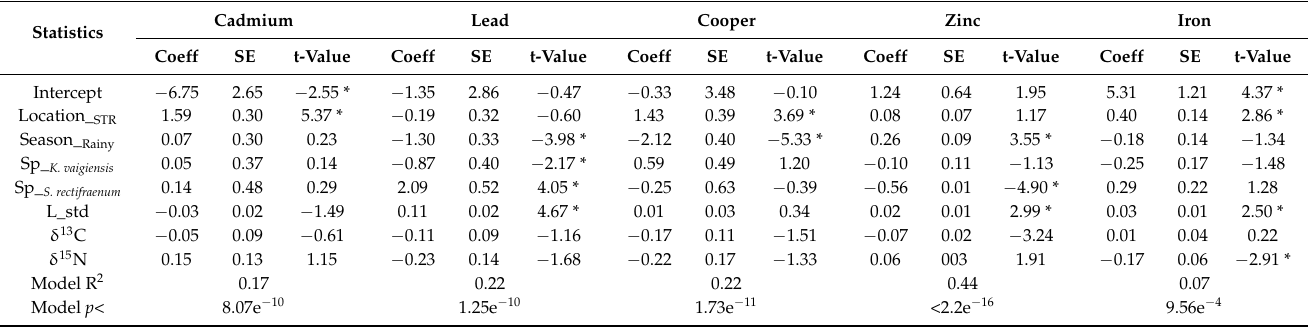
Table 4. Multiple categorical regression results.